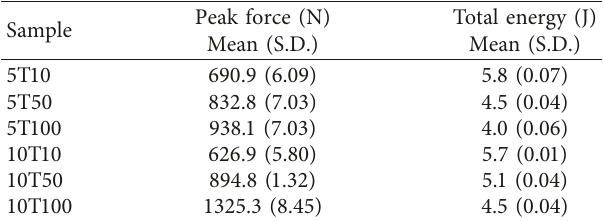
Figure 4: 5T10, 5T50, 5T100, 10T10, 10T50, and 10T100 shock absorption in relation to the printing conditions. Table 4: Peak force and total energy of absorption.